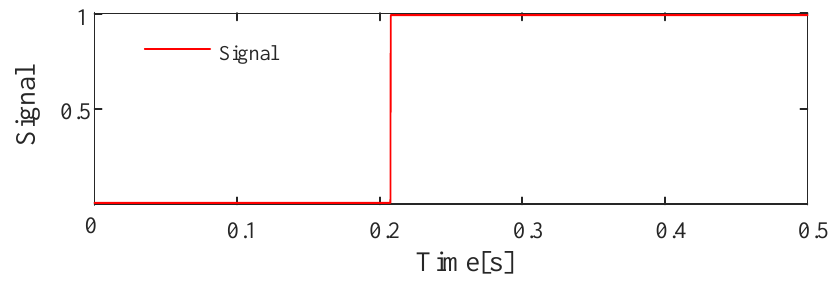
Figure 13. Fault detection signal.